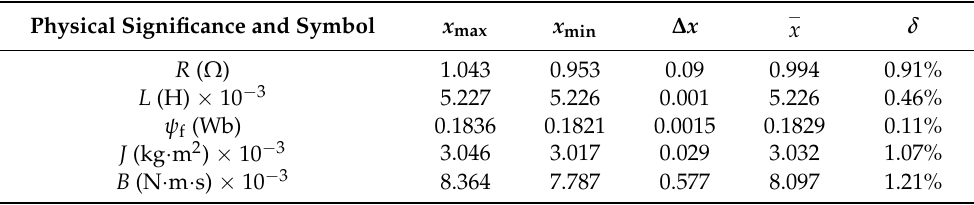
Table 5. Multiparameter identification of the PMSM result based on the MRAS-SAPSO